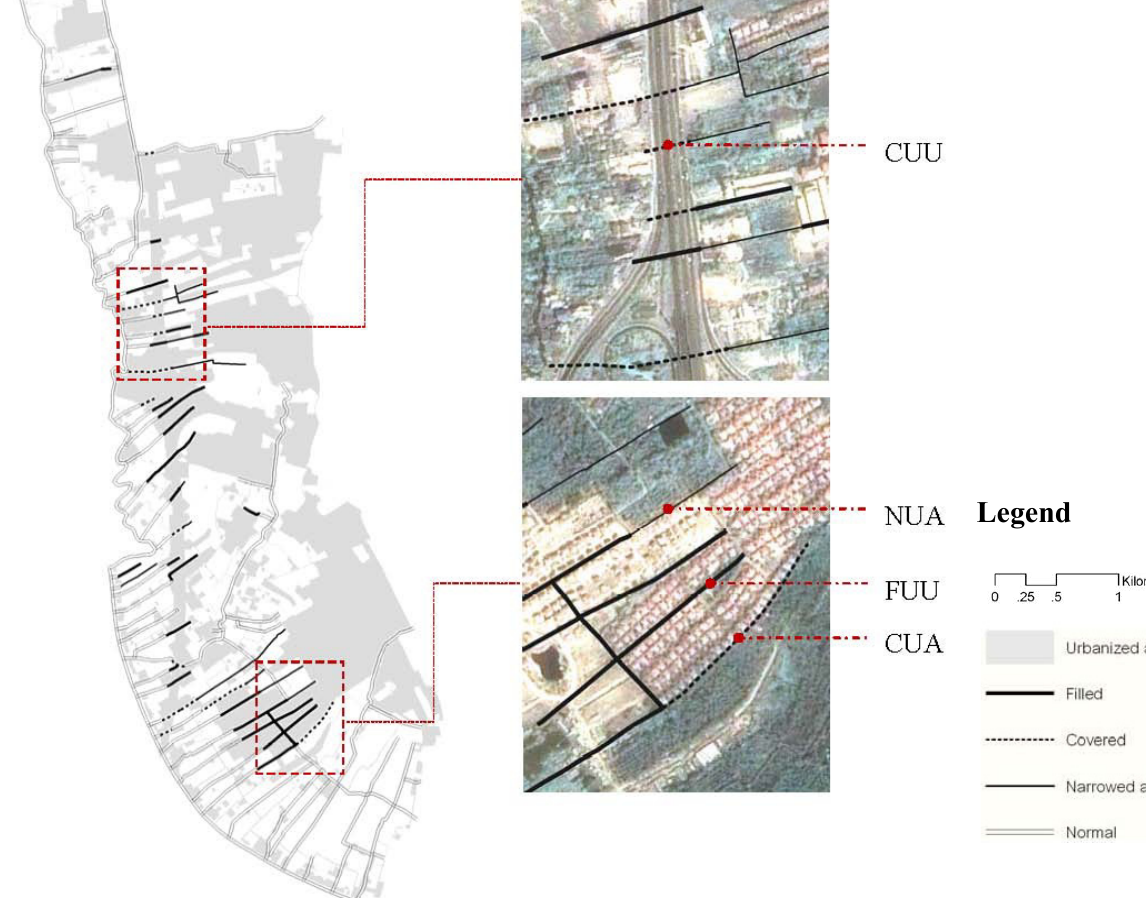
Figure 8. Relationship of canal deterioration and urbanization ( a ) Map of canal deterioration located inside and outside urbanized area. ( b ) Satellite image showing different types of land configurations in relationship with canal deterioration.